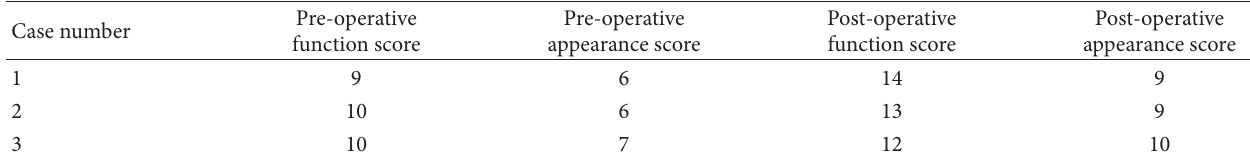
T 4: Pre-operative and post-operative assessment of functional and appearance score of all the 3 cases by using Hazel-Baker’s assessment